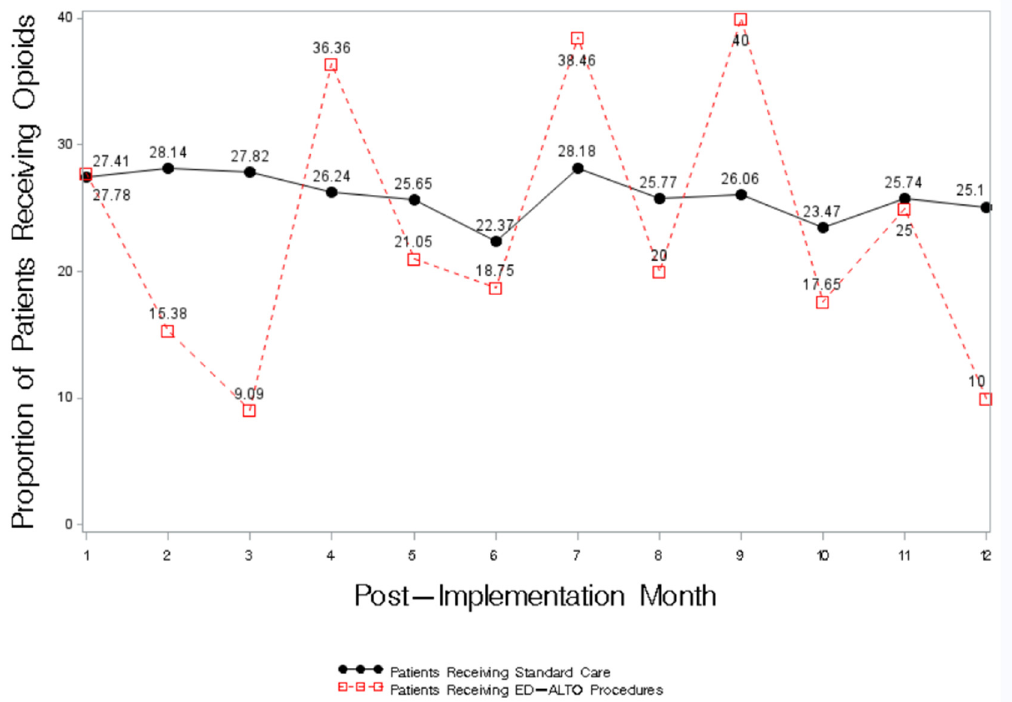
Figure 1. Proportion of Patients Receiving an Opioid prescription in the ED According to ED-ALTO Procedure Status. Procedure Status.